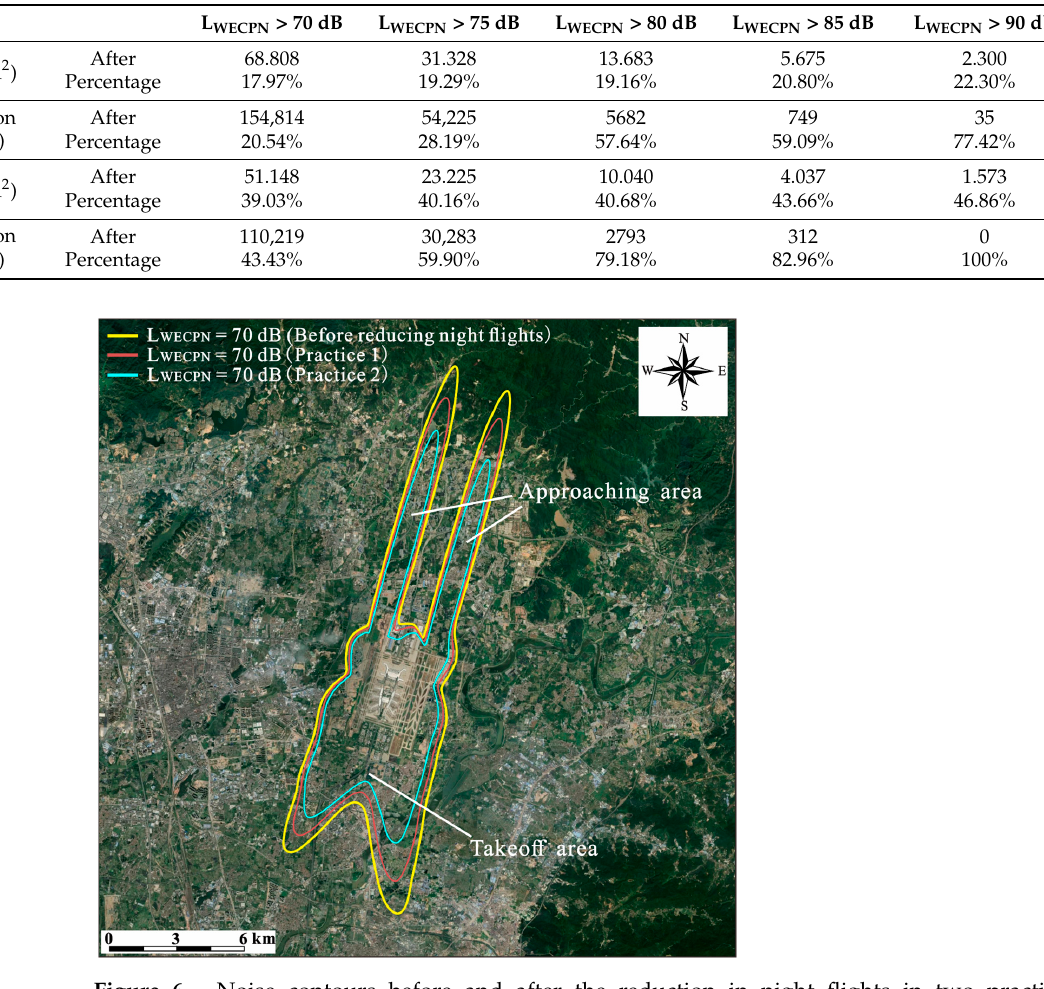
Figure 6. Noise contours before and after the reduction in night flights in two practices during sum-